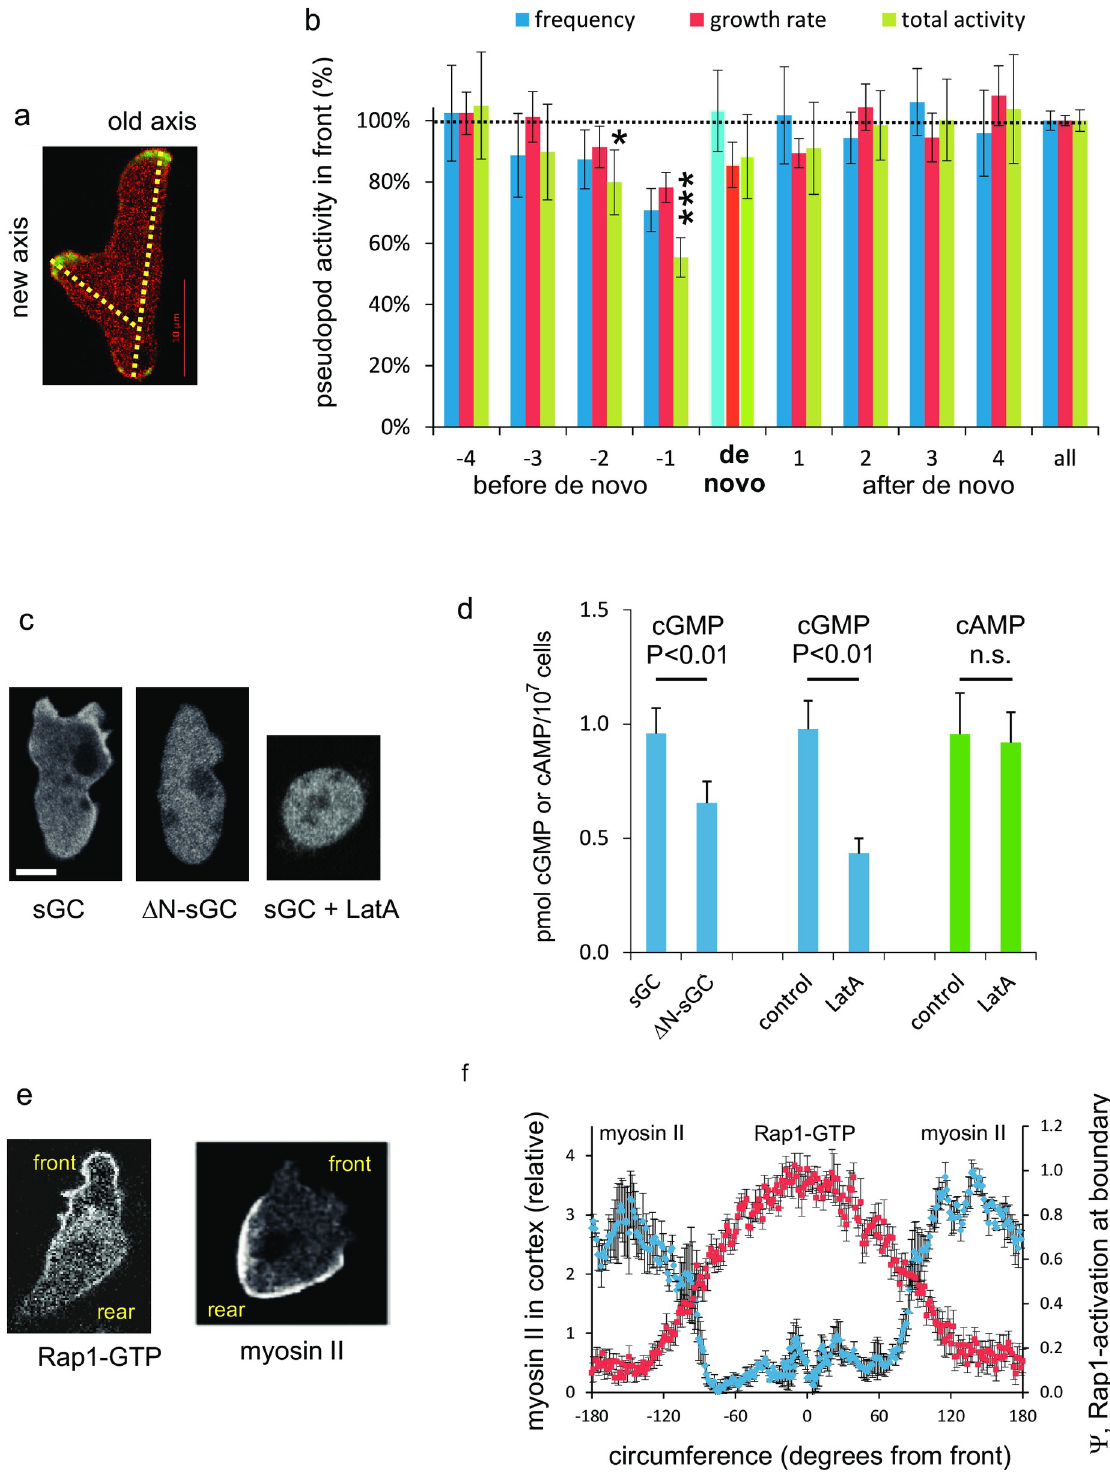
Fig 5. Cells memorize the polarity axis by pseudopod activity and sGC activity in the front. a. Wild-type cells expressing LimE-GFP (detecting F-actin) and myosin II-RFP. A de novo pseudopod can generate a new polarity axis. b. Pseudopod activity in the front before and after the extension of a de novo pseudopod. Measured were the pseudopod frequency (in 1/s), pseudopod growth rate (in μ m/s) and their product. Data are the means and SEM of 98 de novo pseudopods. ��� , significantly different from the data value for all pseudopods at